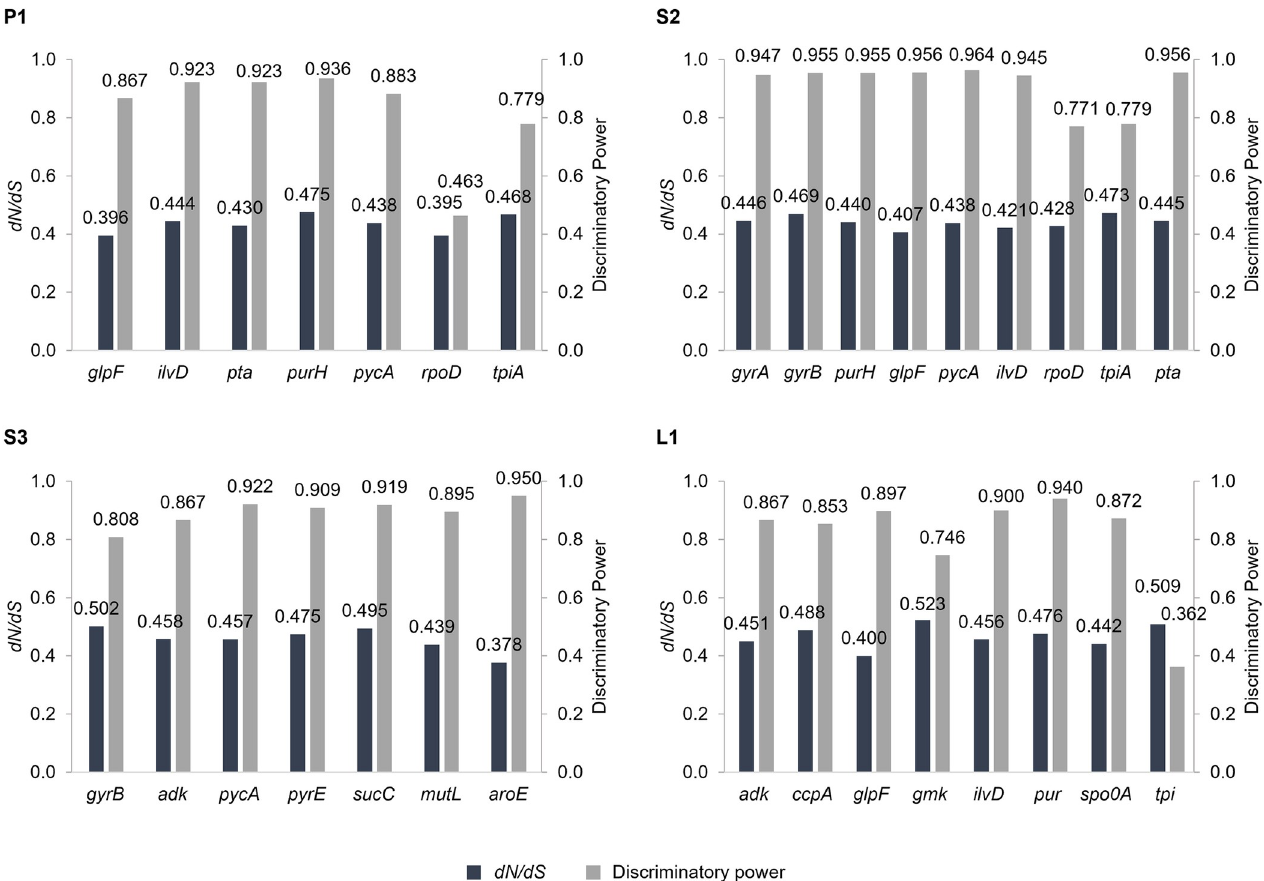
Fig 2. Non-synonymous nucleotide substitutions per site/synonymous nucleotide substitutions per site ( dN/dS ) values and discriminatory power of four MLST schemes.